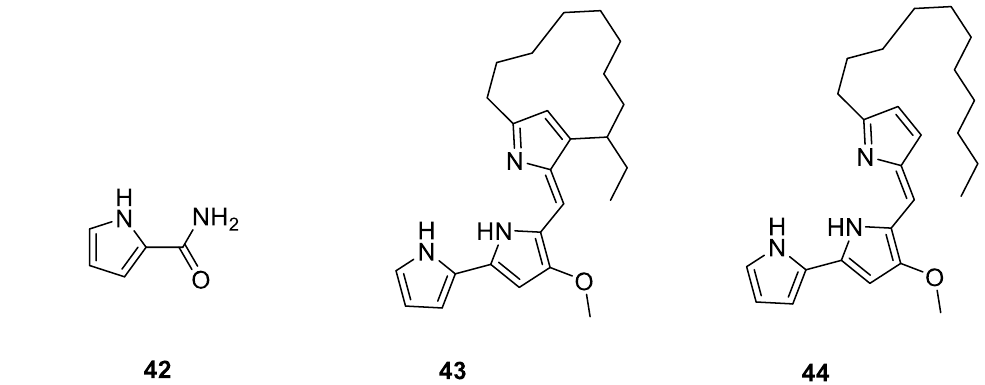
Figure 6. Chemical structures of compounds 41 − 44 from lichen-associated actinomycetota.